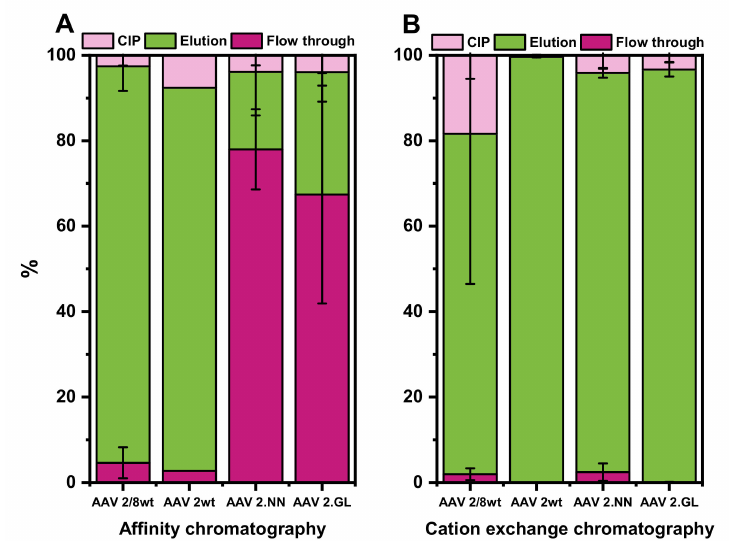
Figure 7. Comparison of AC and CEX for rAAV2/8, rAAV2/2, rAAV2/2.GL, and rAAV2/2.NN. Chromatography with AC ( A ) and CEX ( B ). Purple depicts the flow through and, thus, loss of rAAVs during the loading process onto the column (flowthrough), light green shows the yield of rAAV in the elution, and pink illustrates the loss of rAAVs during the cleaning in place (CIP) process. Minimum, n = 3 (except for AC rAAV2/2, n = 2)). rAAV, recombinant adeno-associated